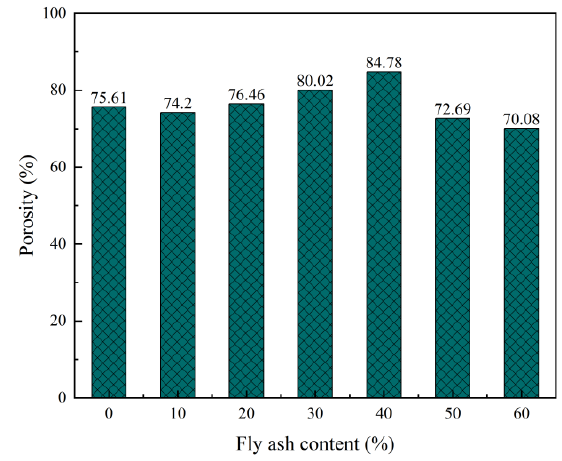
Figure 9. Effect of calcium stearate content on pore size distribution frequency of foam concrete.